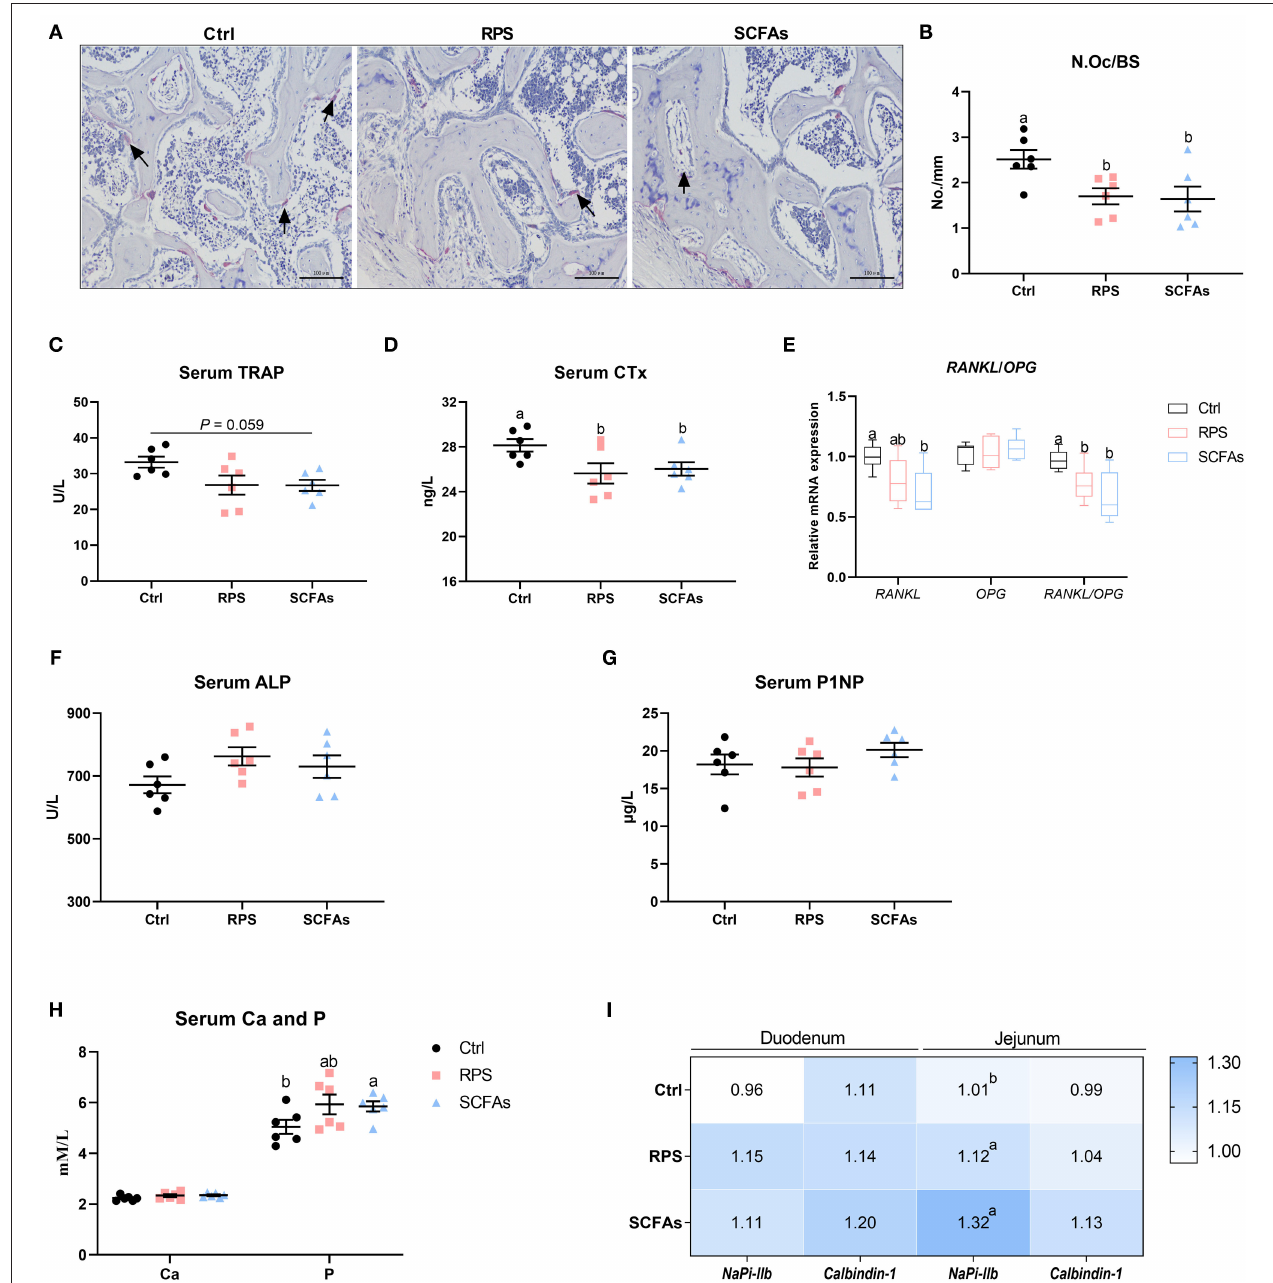
FIGURE 3 | Dietary RPS and drinking SCFAs administration suppressed osteoclastic bone resorption and induced phosphorus (P) absorption in meat ducks. (A) Tartrate resistant acid phosphatase (TRAP) staining of tibial sections. Bar = 100 µ m. (B) The number of osteoclast (N.Oc/BS) in proximal tibias was determined by histomorphometry. Circulating (C) TRAP activity and (D) C-terminal cross-linked telopeptide of type I collagen (CTx) concentrations. (E) Real-time (RT)-PCR analysis for mRNA expression of receptor activator for nuclear factor- κ B ligand ( RANKL ) and osteoprogerin ( OPG ) in the proximal end, and the ratio of RANKL / OPG was calculated. Serum bone formation including (F) procollagen type I N-terminal propeptide (P1NP) and (G) alkaline phosphatase (ALP) level, as well as (H) serum calcium (Ca) and phosphorus (P) concentration were evaluated. (I) The mRNA abundance of RT-PCR analysis for mRNA expression of sodium-dependent phosphorus transport protein II ( NaPi-IIb ) and calbindin-1 in duodenum and ileum. Data are expressed as mean and SD. a,b Mean values with different letters are significantly different by one-way analysis of variance followed by Tukey’s post-hoc test ( p < 0.05).